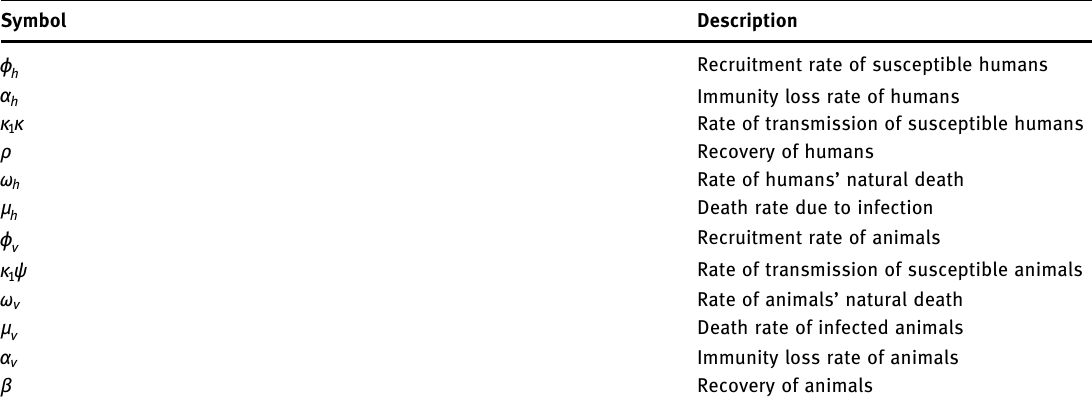
Table 1: Description of the input parameter for system ( 9 ) of zoonotic disease Symbol